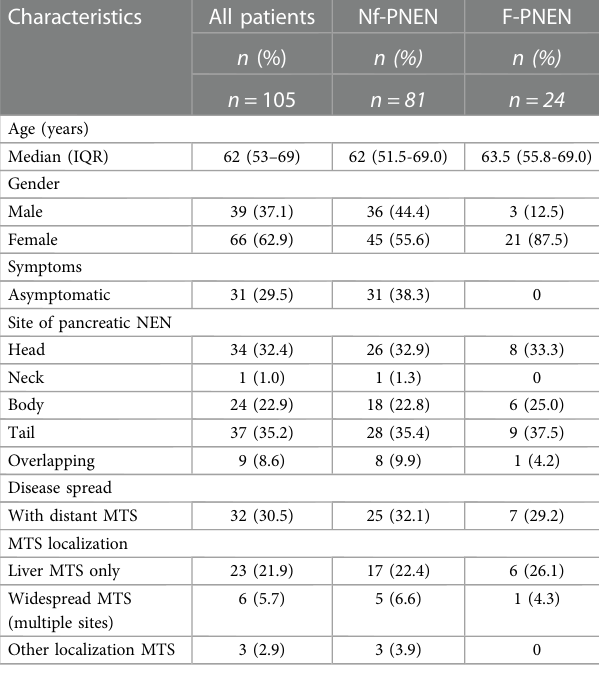
TABLE 1 Baseline characteristics of included patients, tumors, and symptoms. Characteristics